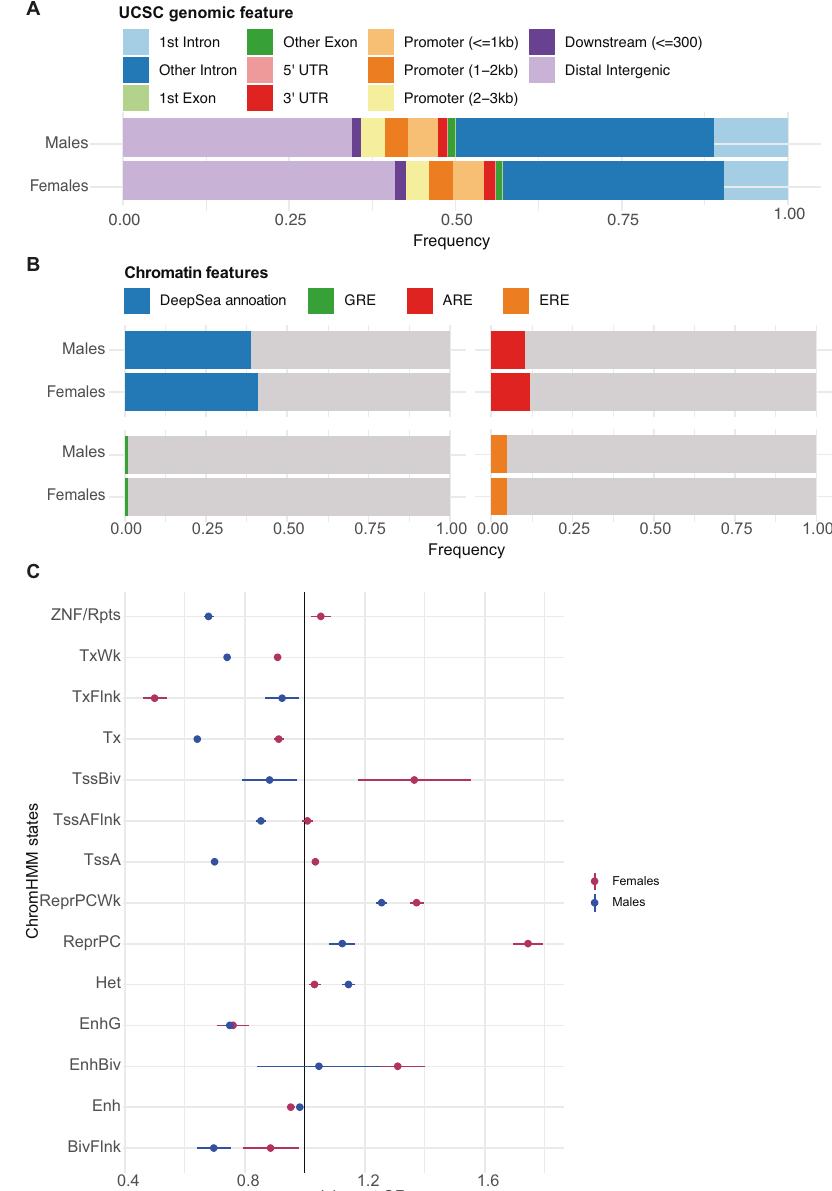
Fig. 4 Sex strati fi ed GR-response cis -eQTL Functional Results. Sex strati fi ed GR-response cis- eQTLs and chromatin annotation: A Annotation of the genomic regions in which eSNPs are located. B Bar plots showing the overlap of GR-eSNPs and DeepSea annotations, Remap transcript factors (AR and ER) and Encode GR-Chip peaks. C Enrichment results for GR-response tag eSNPs and predicted ChromHMM states for sex- strati fi ed tag